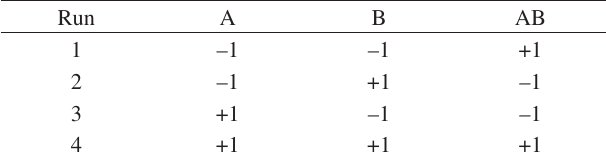
Table 1. Experimental array of Factorial design 2 2